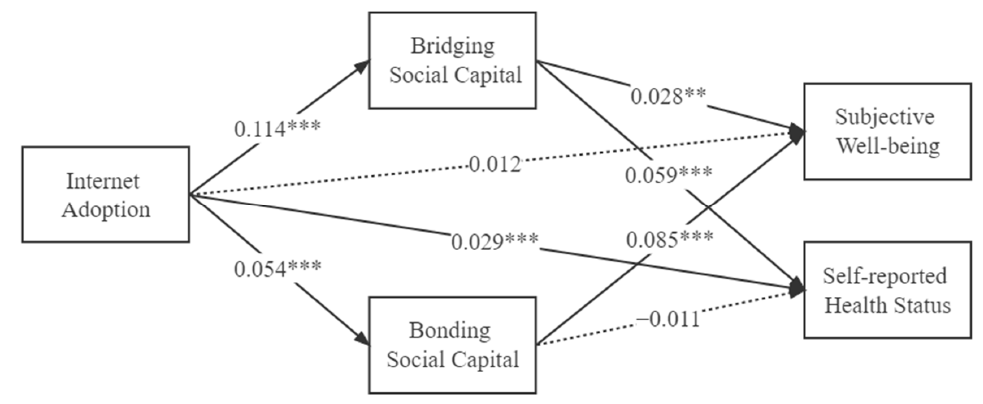
Figure 2. Results of structural equation modeling. Note: *** p < 0.01, ** p < 0.05.